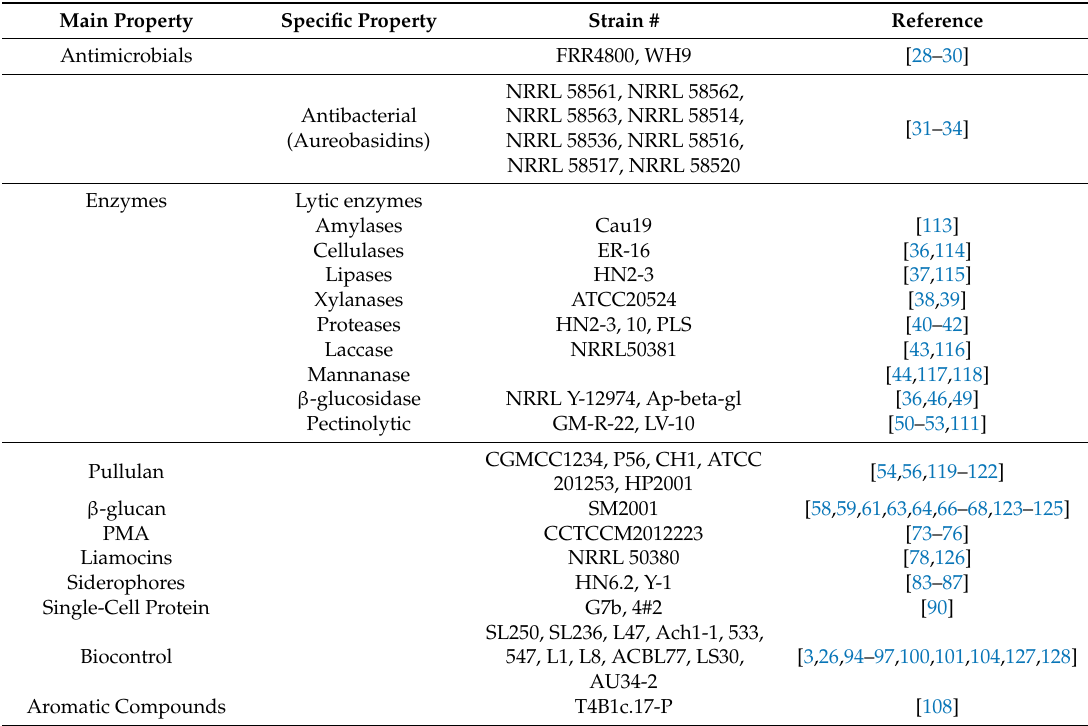
Table 1. Aureobasidium pullulans main